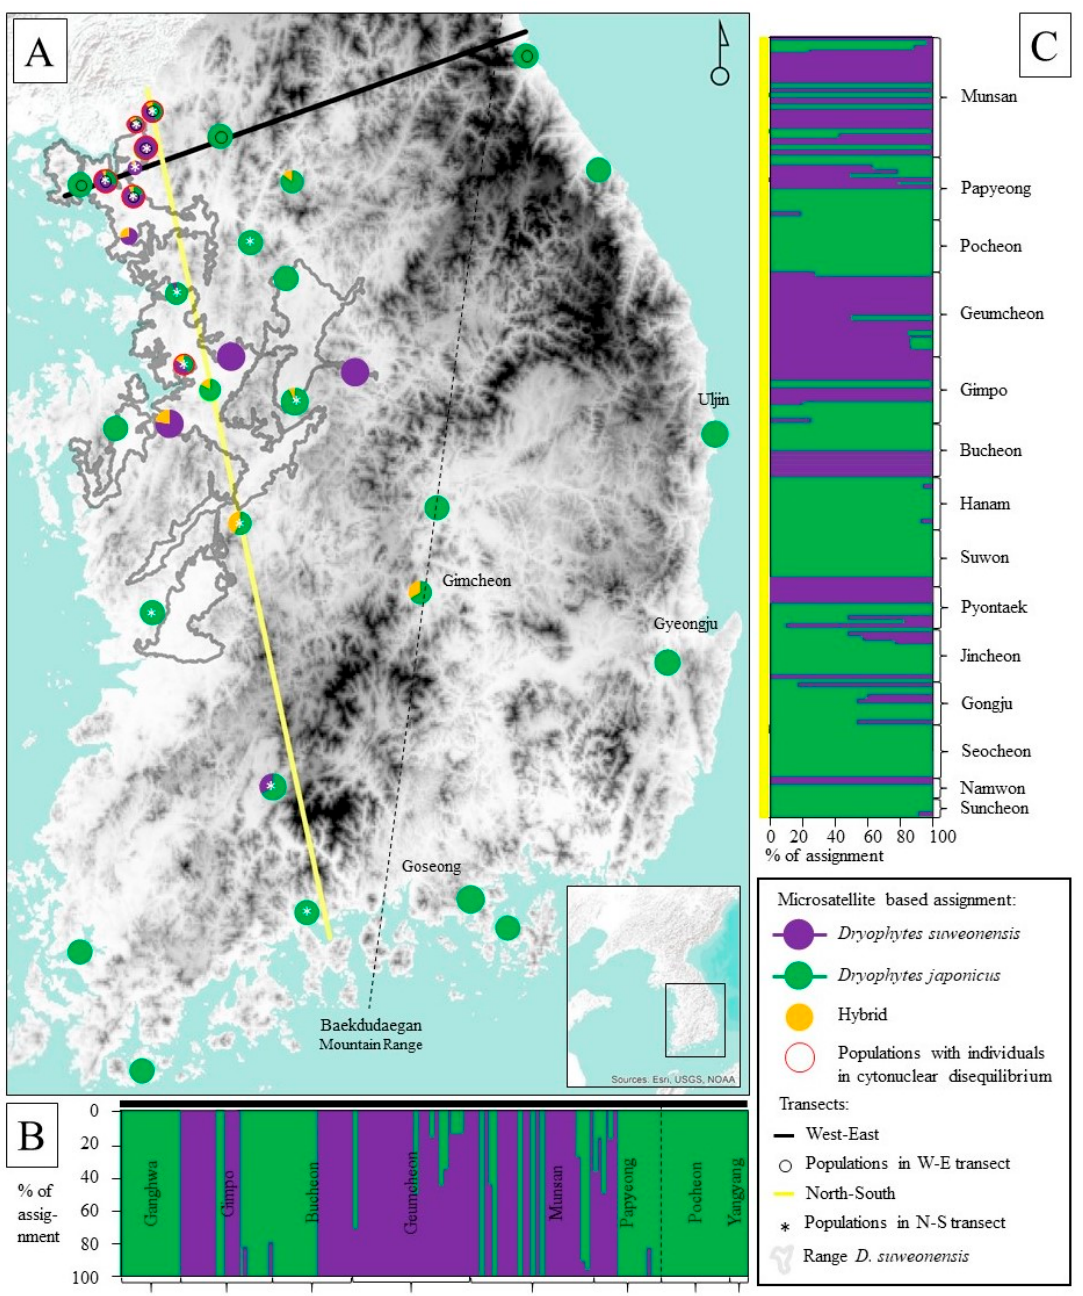
Figure 4. Structure analysis of microsatellite data, assigning each individual from populations selected for the transects to a clade based on percentage of assignment. ( A ) Pie charts represent the percentage of non-hybrid and hybrid individuals for each population, whereas the two transects (( B )—west–east; ( C )–north–south; the names of localities are listed along the corresponding cardinal gradient and can be matched with the population following the annotated order on the map) represent individual assignments within populations. Structure assignments were drawn only if reaching the 10%